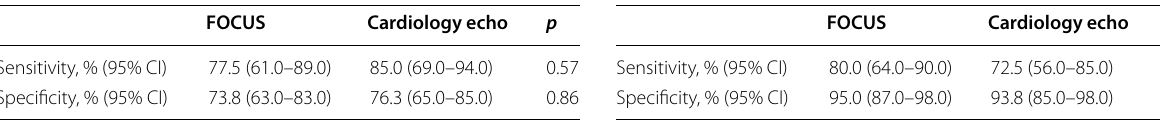
Table 6 Performance metrics of classroom interpretation Table 7 Performance metrics of classroom